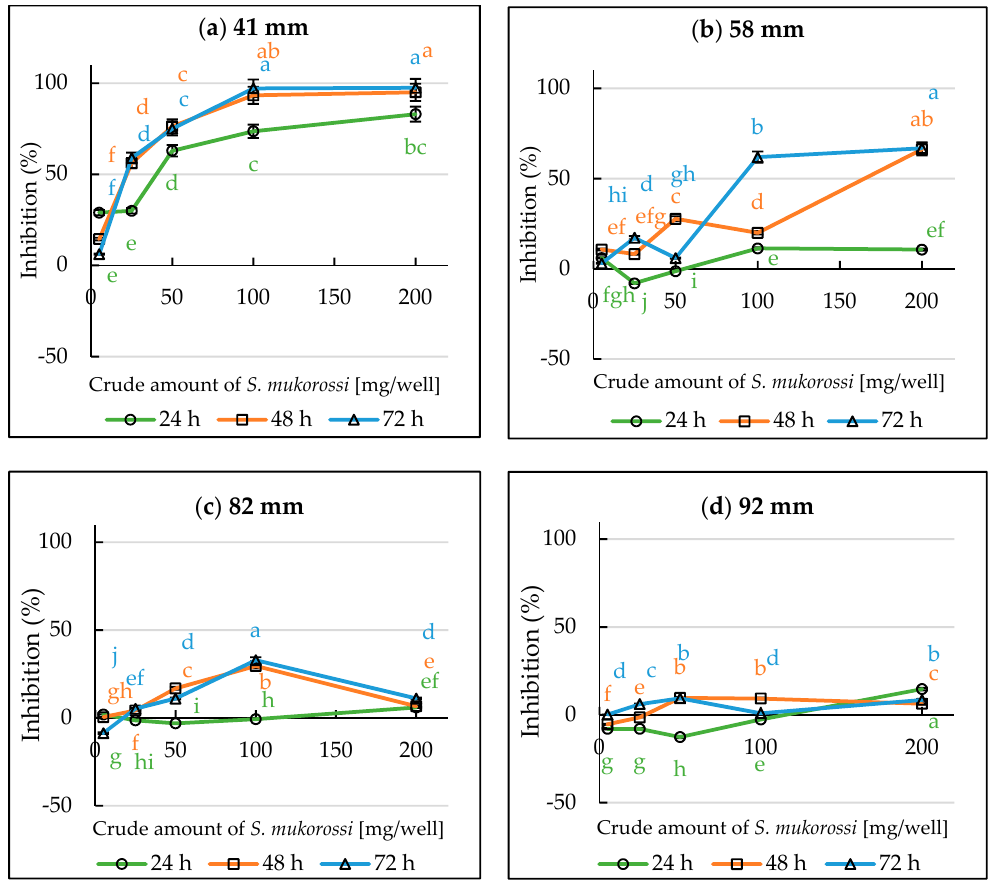
Figure 7. Control level of radicle growth percentage: ( a ) 41 mm distance from source well, ( b ) 58 mm distance from source well, ( c ) 82 mm distance from source well, and ( d ) 92 mm distance from source well, considering the amount of variation of S. mukorossi dry samples (200 mg, 100 mg, 50 mg, 25 mg, 5 mg) on the growth control variable by the DP method of L. sativa seedlings. The data compared by Tukey’s HSD test and values are the averages of three replications of ( ± ) standard error.